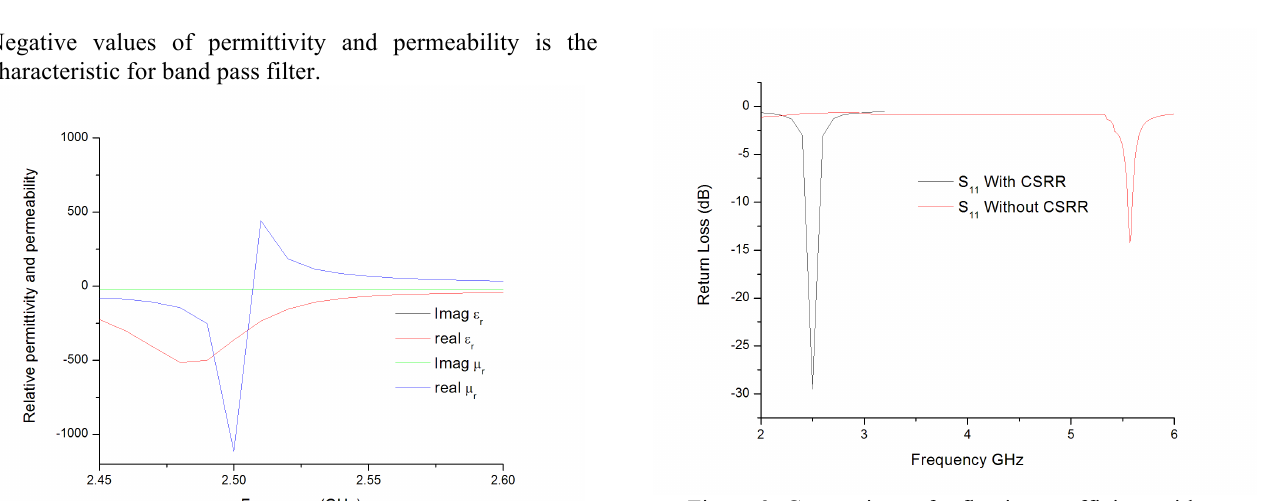
Figure 3: Comparison of reflection coefficient with and without CSRR loaded patch